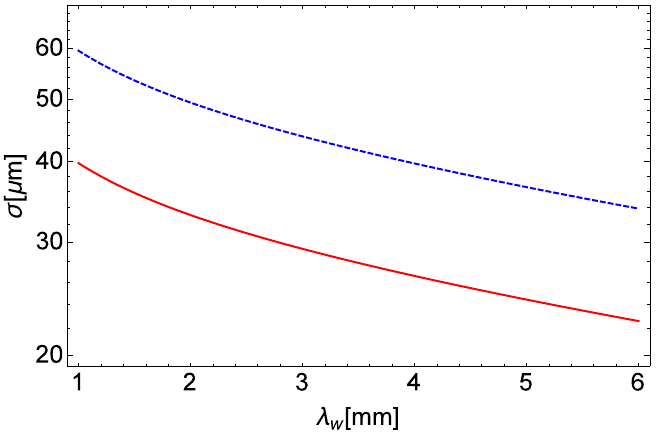
Figure 4. Electron beam cross section ( µ m) vs. the undulator wavelength for λ r ≡ 1 nm (continuous red line) and λ r ≡ 5 nm (dashed blue line); assuming a normalized emittance value of 1 mm mrad with a β x , y Twiss value of 5 m/2 π and using the Equation 3 with the same parameters reported in Figure 2.